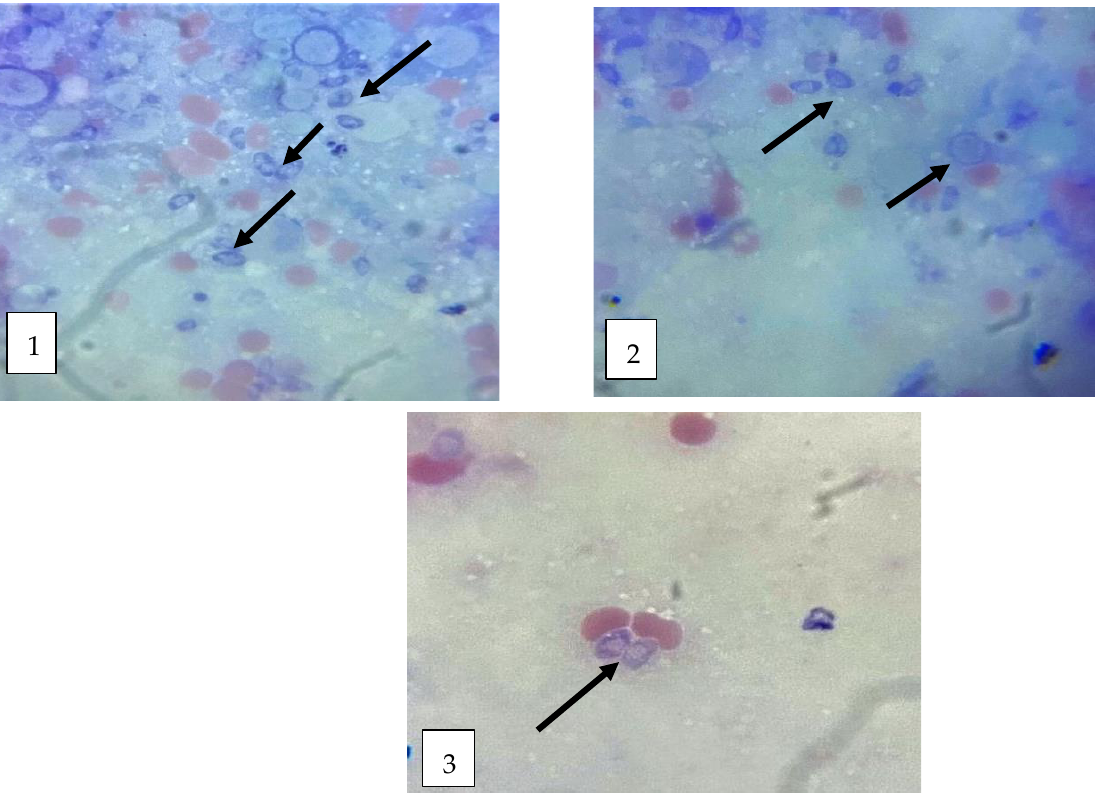
Figure 5. T. gondii tachyzoites of infected mice treated with ZnO-MWCNT in Giemsa-stained liver ( 1 ), Spleen ( 2 ) and brain ( 3 ) impression smear, × 1000.